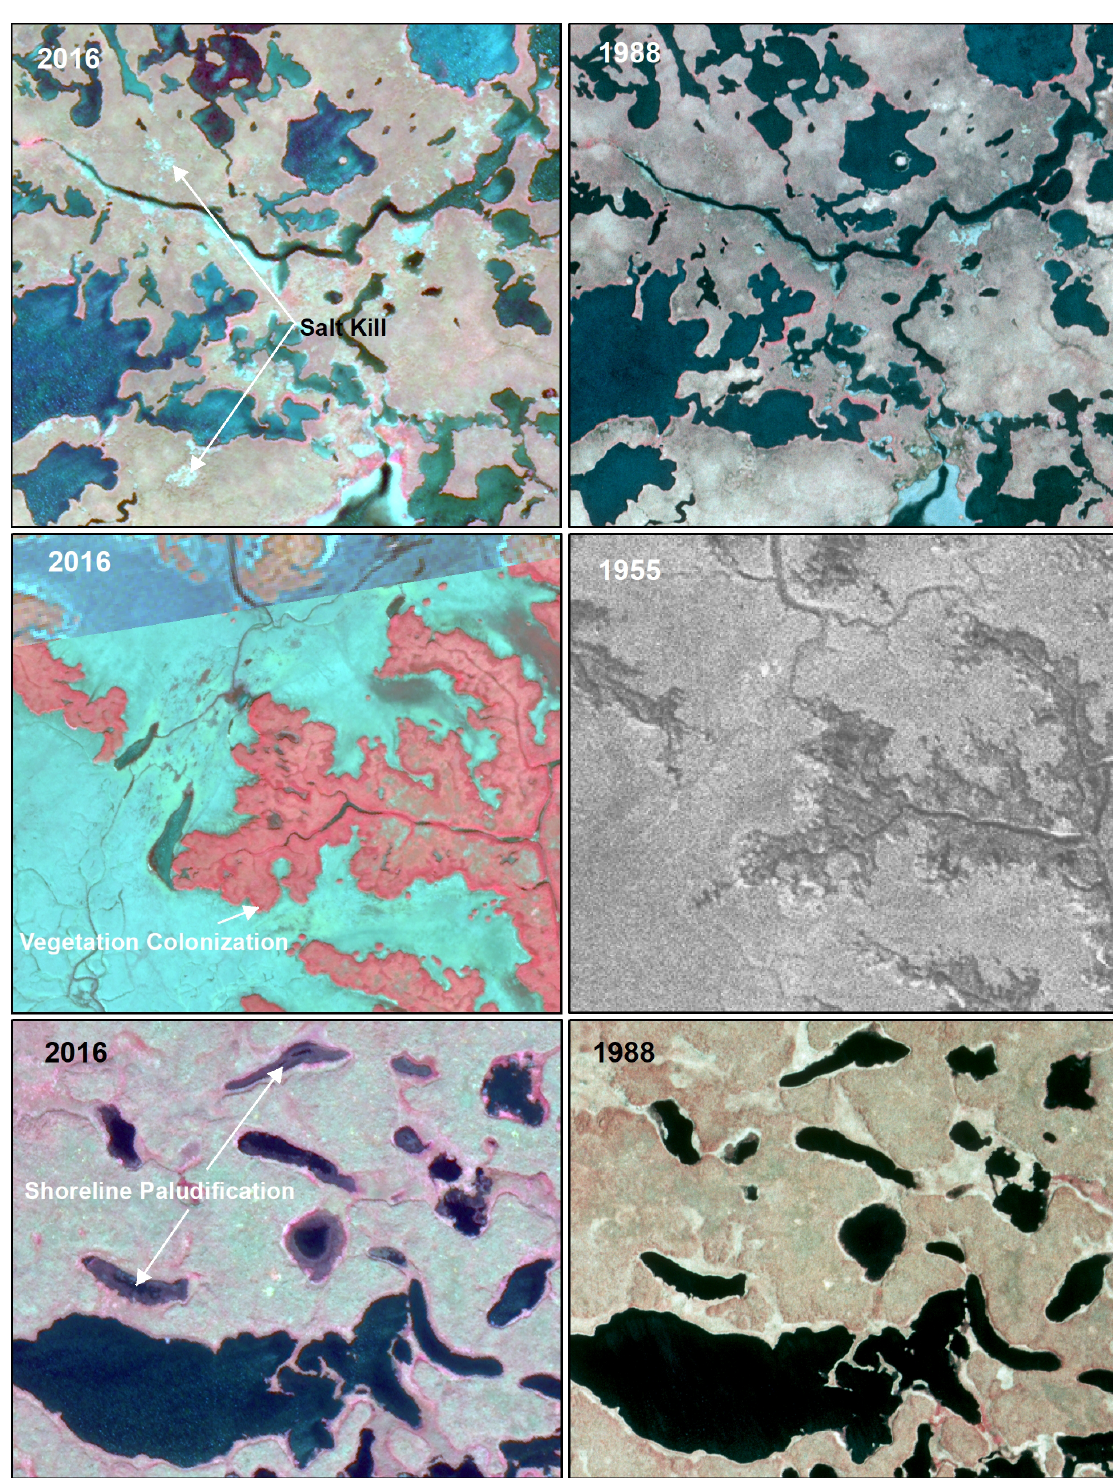
Figure 5. Examples of landscape change due to salt-kill from storm surges, vegetation colonization of tidal flats and shoreline paludification evident on imagery from 1955, 1988 and 2016 along the central coast of the Yukon-Kuskokwim Delta. 2016 imagery © Digital Globe, NextView